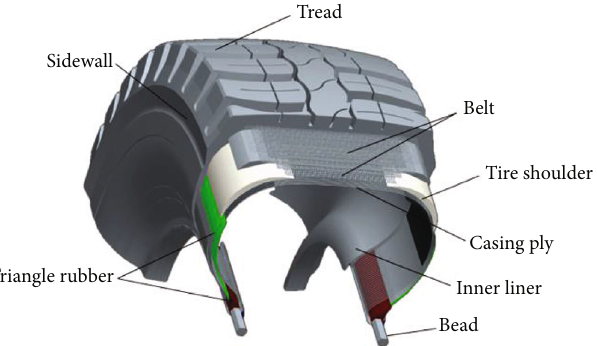
Figure 1: Schematic of tire